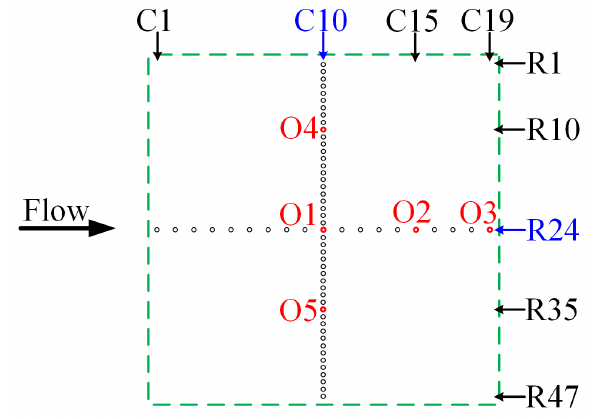
Figure 10. Orifices at which velocity characteristics of the synthetic jets were measured. Positions of the orifices were O1(R24, C10), O2(R24, C15), O3(R24, C19), O4(R10, C10), and O5(R35,